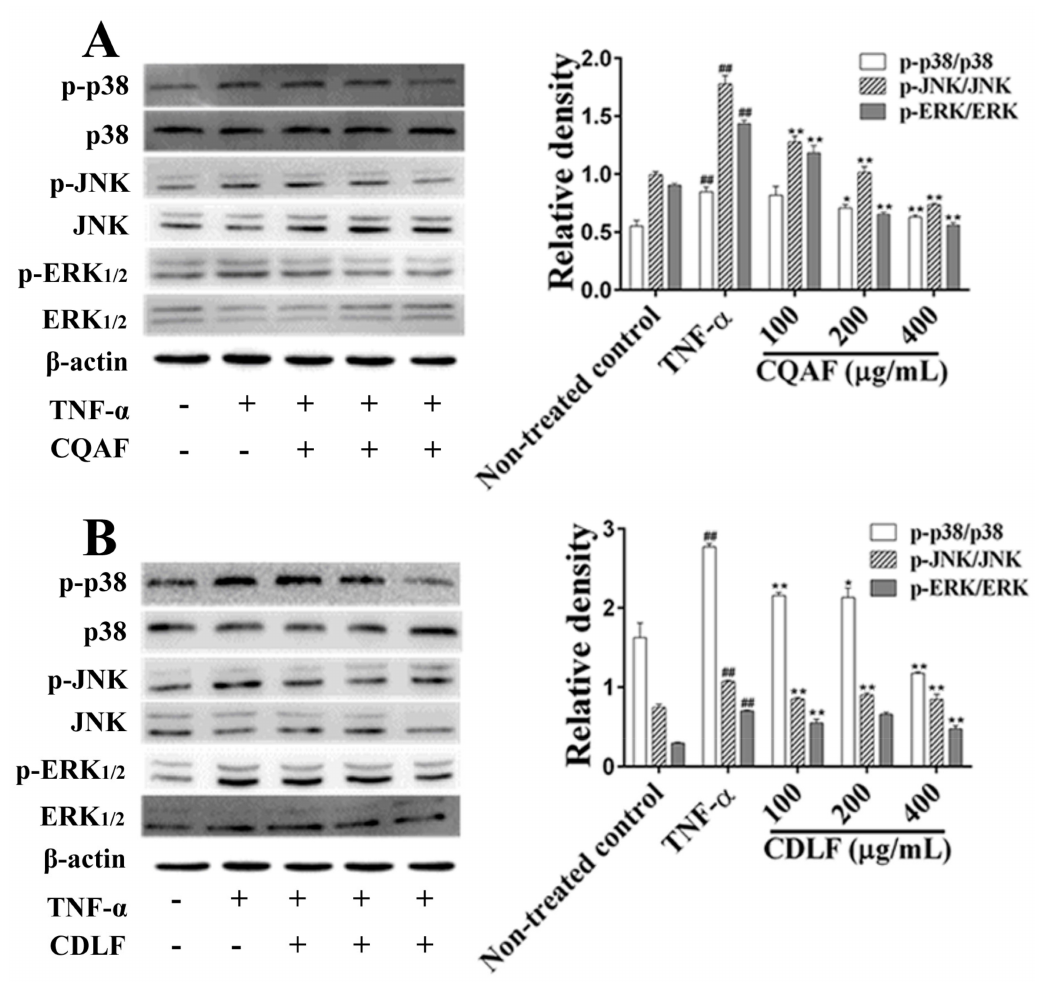
Figure 9. Effects of CDLF and CQAF on the protein expressions of p38, ERK, and JNK phosphorylation in MH7A cells. The cells were treated with CDLF or CQAF at various concentrations (100–400 µ g/mL for 24 h in the presence of TNF- α (50 ng/mL). β -Actin was used as the internal control. ( A ) CQAF treatment; ( B ) CDLF treatment. The data are presented as the mean ± SD ( n = 3). ## p < 0.01 when compared with the non-treated control group, * p < 0.05, ** p < 0.01 when compared with the TNF-